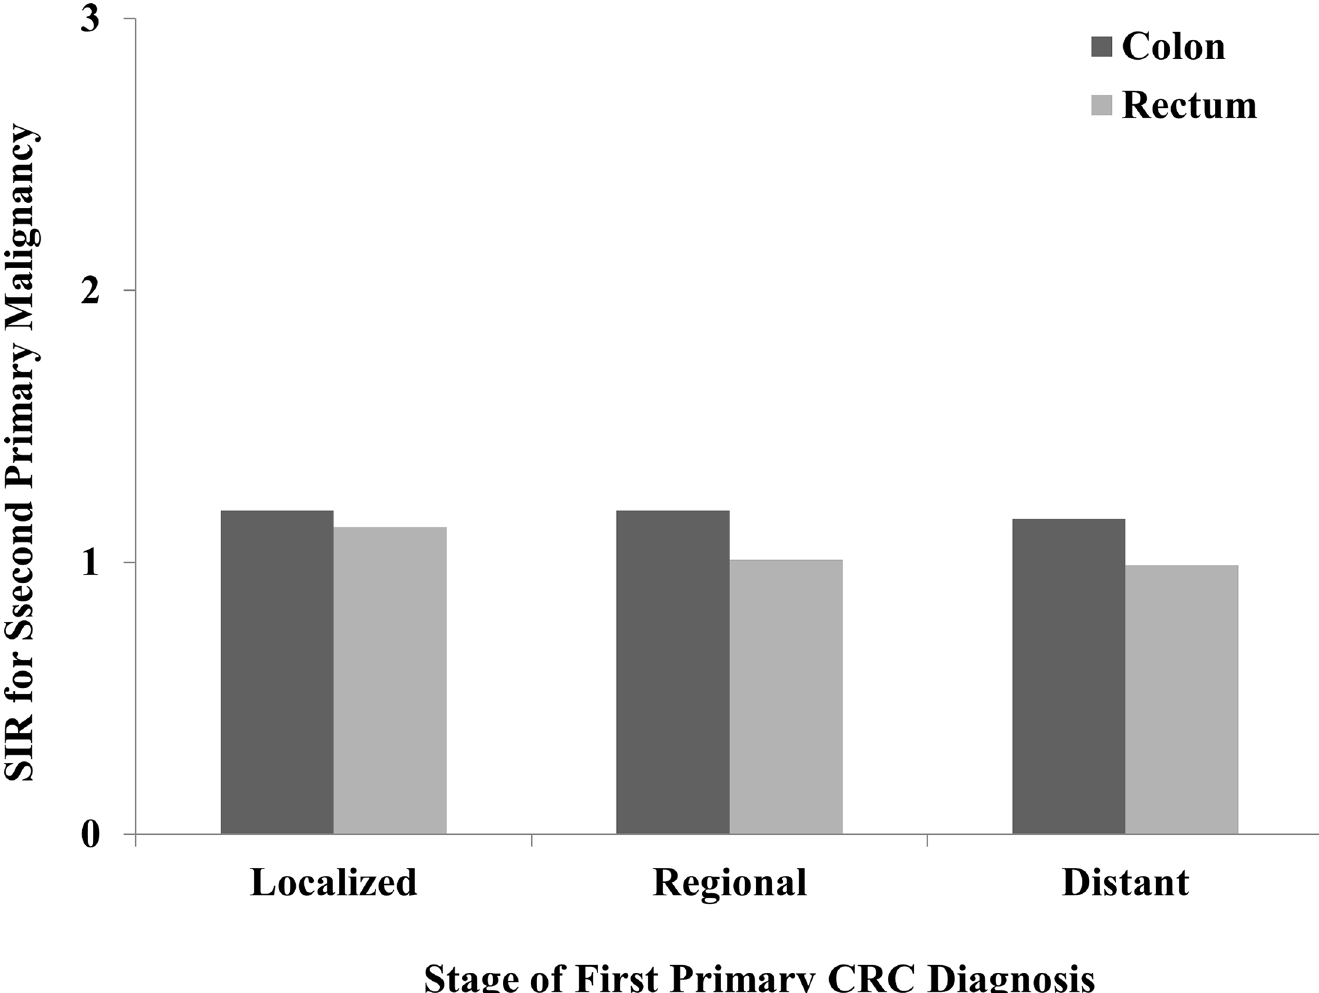
Fig 4. SIRs of SPMs in colon and rectal cancer patients by